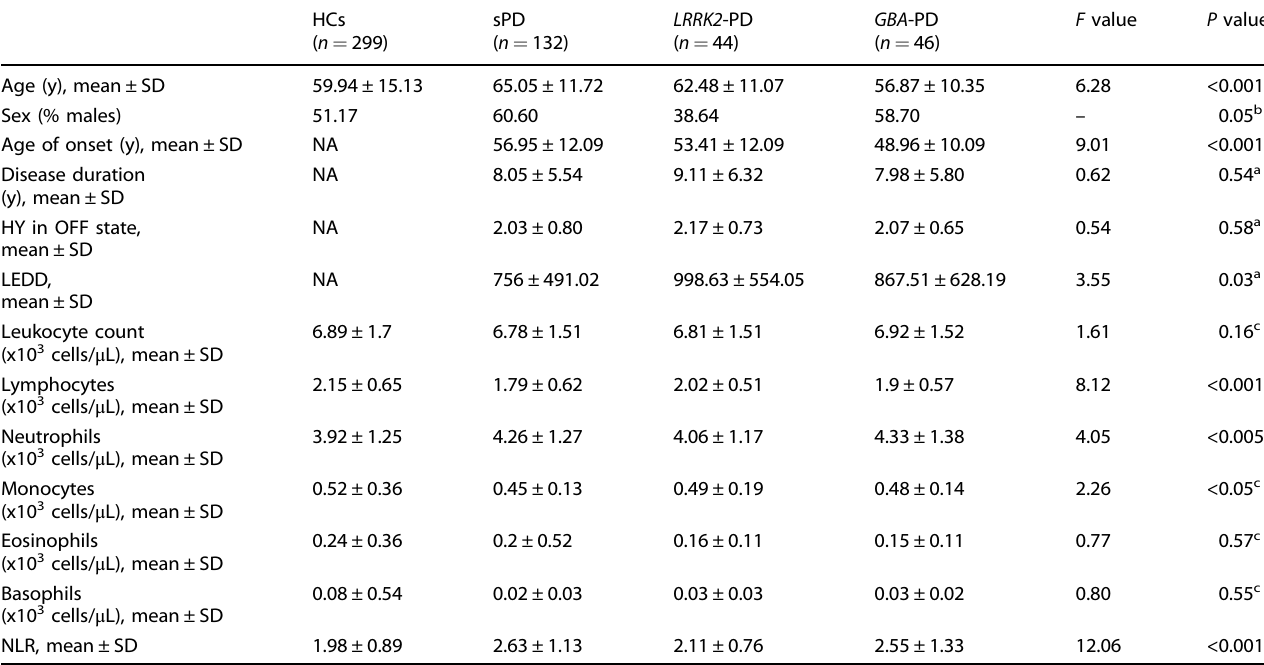
Table 2. Demographic and clinical data, and peripheral immune pro fi le of healthy controls and Parkinson ’ s disease genetic cohorts of the discovery